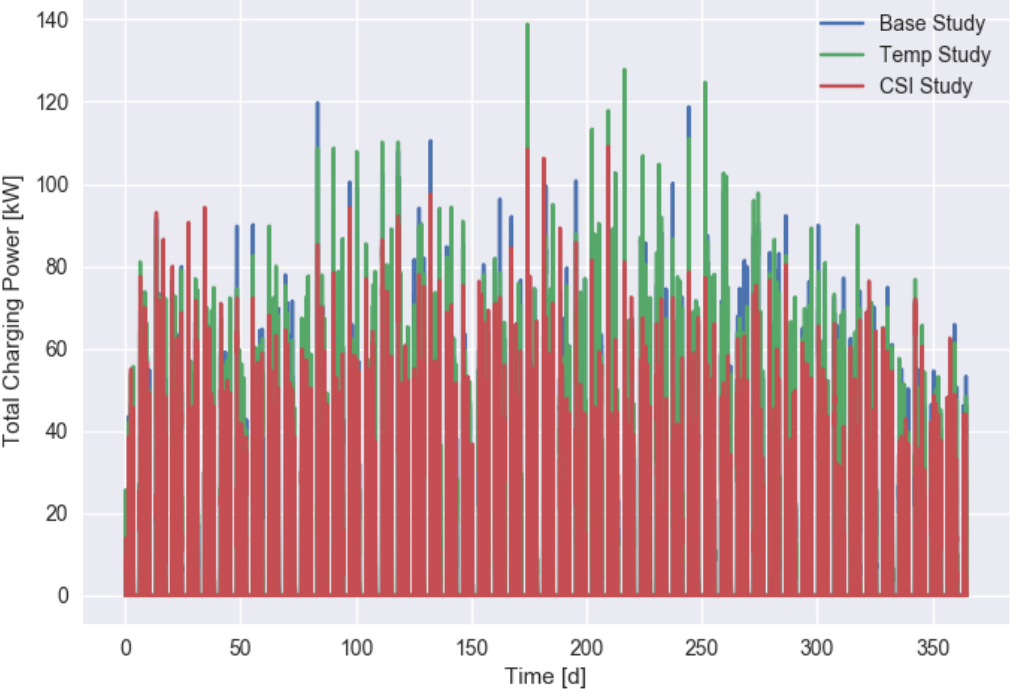
Figure 6. EV charging power (for all vehicles) for different scenarios.